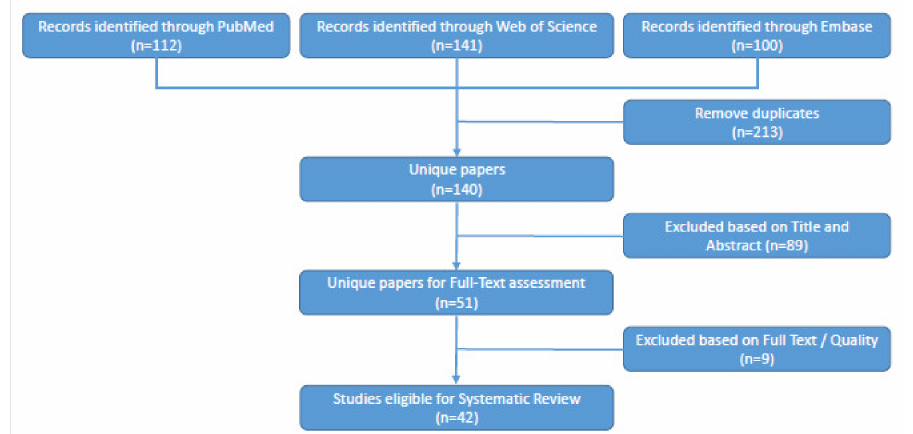
Figure 1. Flowchart explaining the systematic literature search. All retrieved papers were screened, and duplicates were removed, followed by exclusion based on title and abstract, full text, or quality.